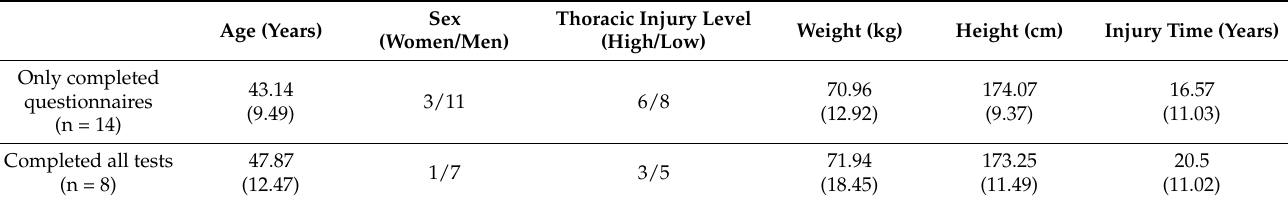
Table 1. Participant